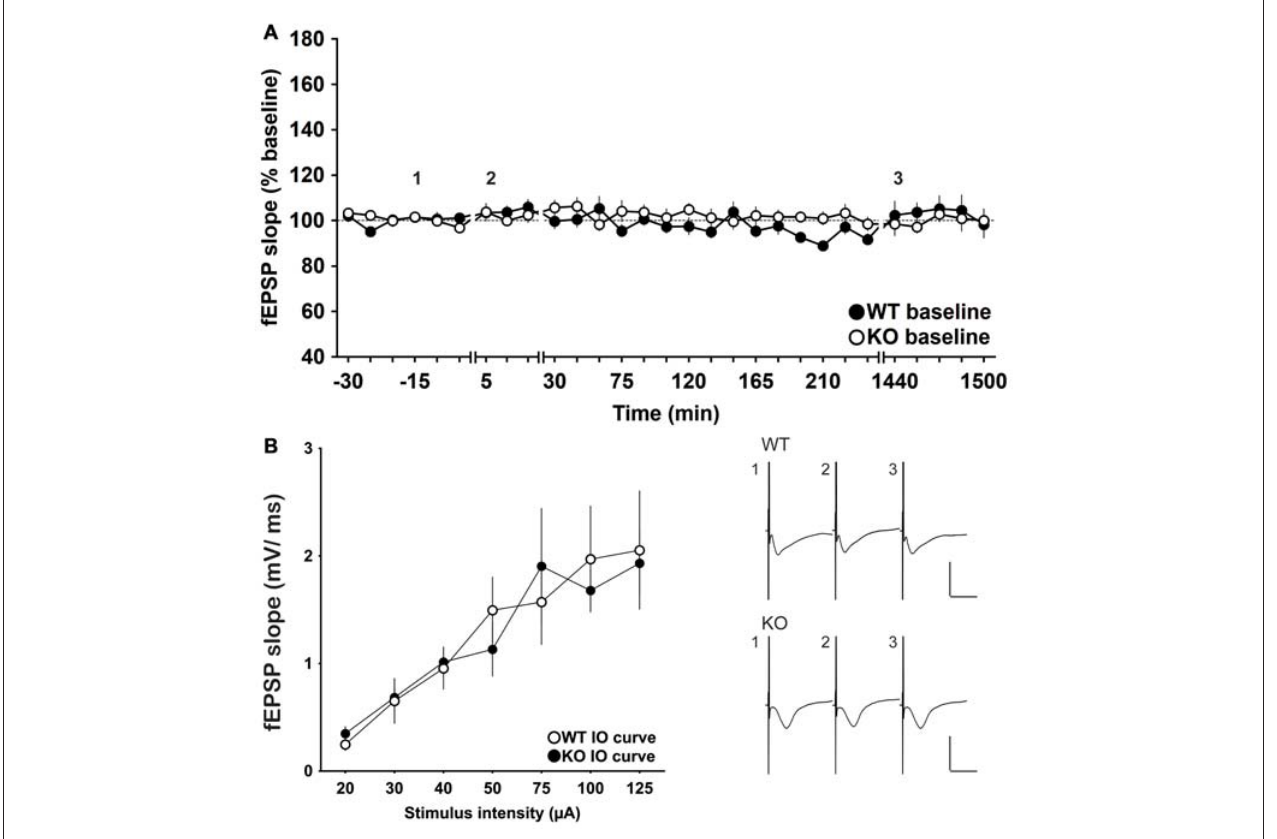
FIGURE 1 | Basal synaptic transmission and input/output (IO) properties are equivalent in freely behaving GluN2A-knockout (KO) mice compared to wildtypes. (A) Field excitatory postsynaptic potentials (fEPSPs) evoked by test-pulse stimulation were stable and comparable in wild-type (WT) and GluN2A-KO mice over the 25 h monitoring period (“Baseline”). (B) IO properties were similar in WT and KO mice. The stimulus intensity was increased stepwise in the range of 20–125 µ A. Insets: examples of fEPSPs evoked at the time-points indicated by the numbers in (A) . Horizontal scale bar: 10 ms, vertical scale bar: 2